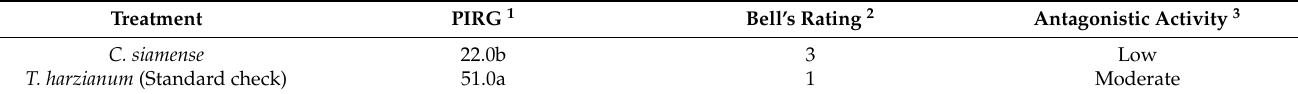
Table 2. Degree of antagonism of C. siamense in co-cultivation with P. palmivora , 7 days after incubation period (DAIP). Treatment PIRG 1 Bell’s Rating 2